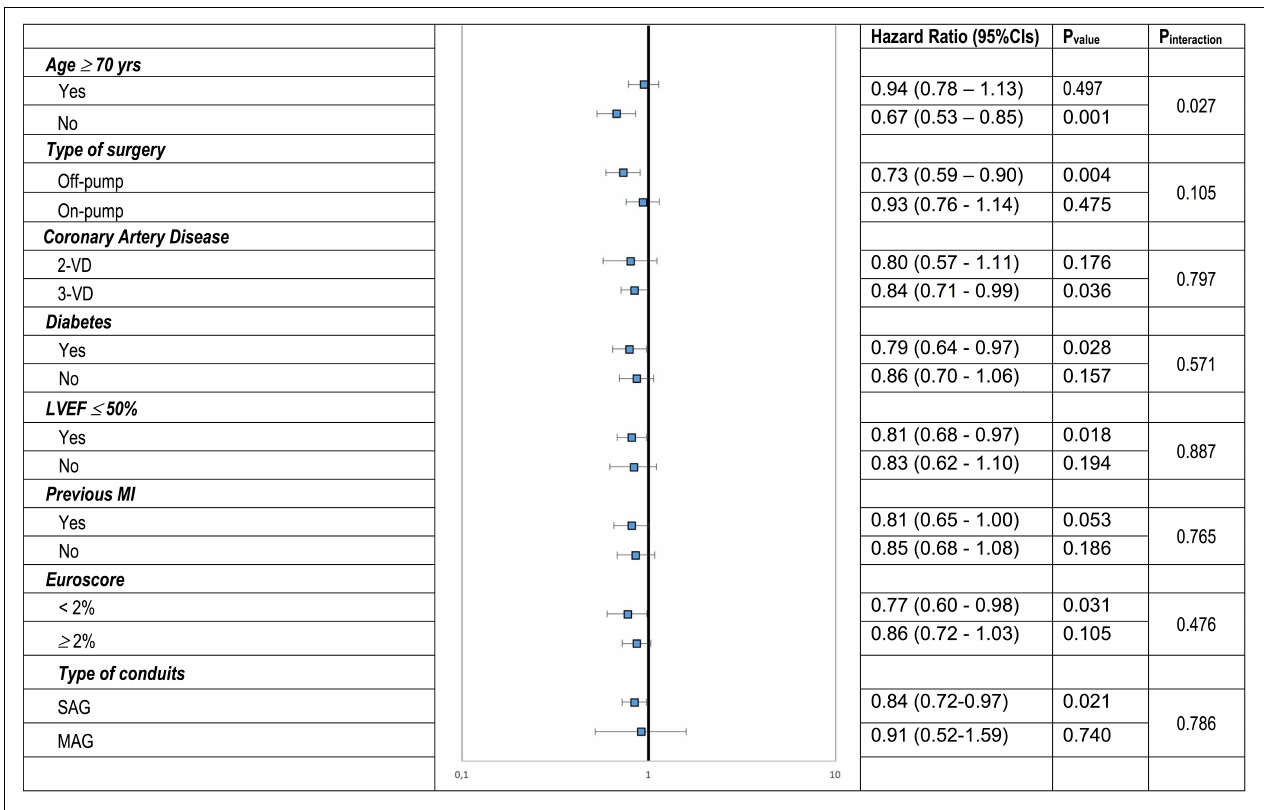
FIGURE 4 | Subgroup Analysis, Hazard Ratios and 95% Confidence Intervals (Cis) for death from any cause in CR as compared to non-CR according to selected characteristics; CR, complete revascularization; VD, vessel disease; LVEF, left ventricle ejection fraction; MI, myocardial infarction.